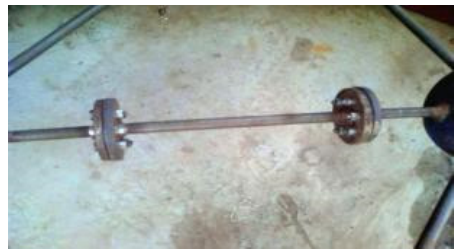
Figure 4. Connection between the model and replacement element. Table 1. Material characteristics of experimental model.